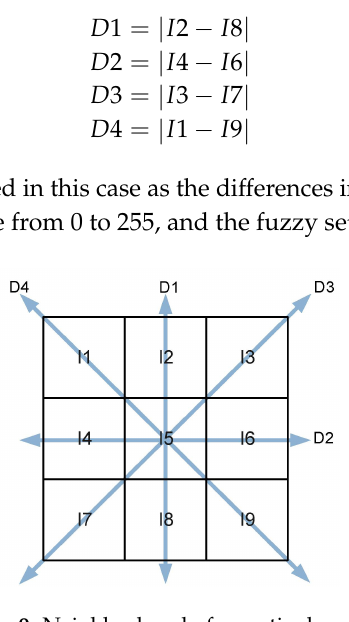
Figure 9. Neighborhood of a particular pixel.